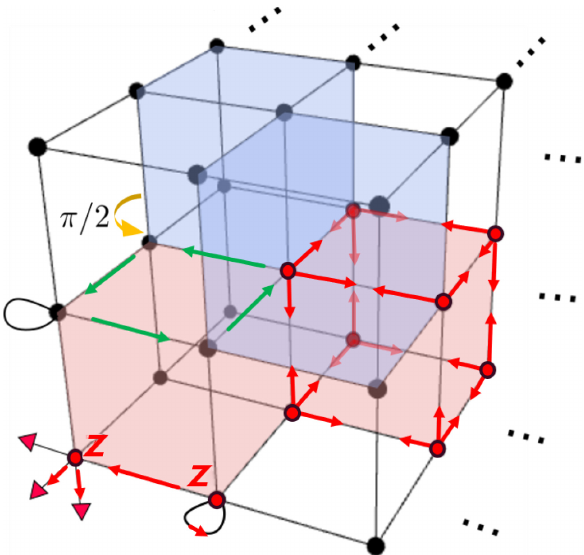
FIG. 25. Pushing logical ¯ Z operators and stabilizers of the Steane tensor produces a boxlike operator flow, which is noth- ing but an all Z stabilizer acting on the dangling physical legs located at the eight corners of a red-colored